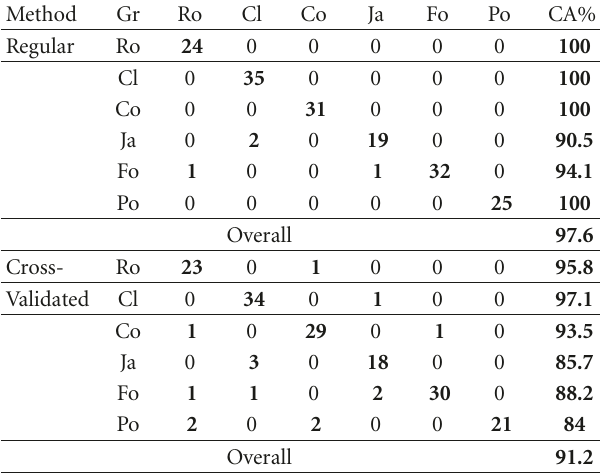
Table 2: Classification results. Method: Regular: linear discrim- inant analysis, Cross-validated: linear discriminant analysis with leave-one-out method, CA%: Classification Accuracy Rate, Gr: Groups, Ro: Rock, Cl: Classical, Co: Country, Ja: Jazz, Fo: Folk and